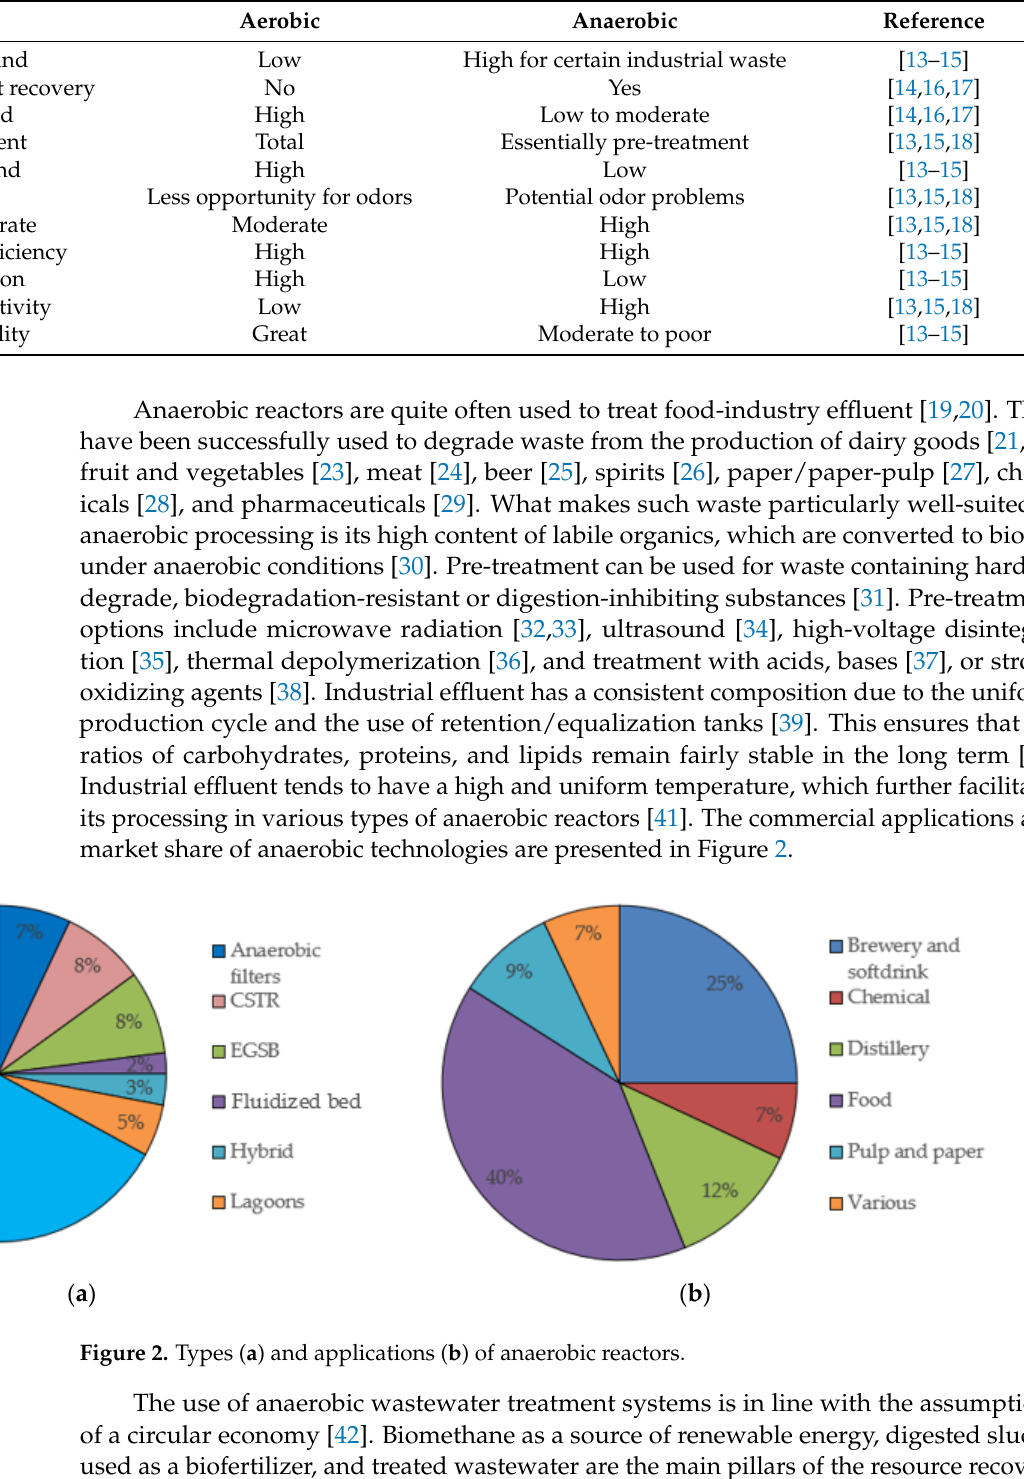
Table 1. General comparison between aerobic and anaerobic wastewater treatment methods.